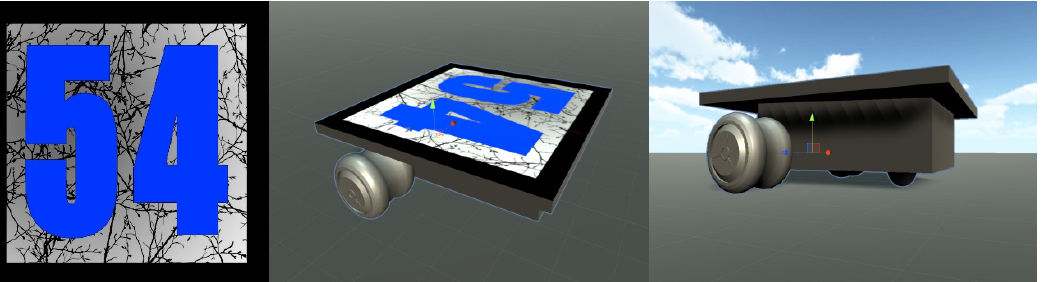
Figure 1. The ground robot images.